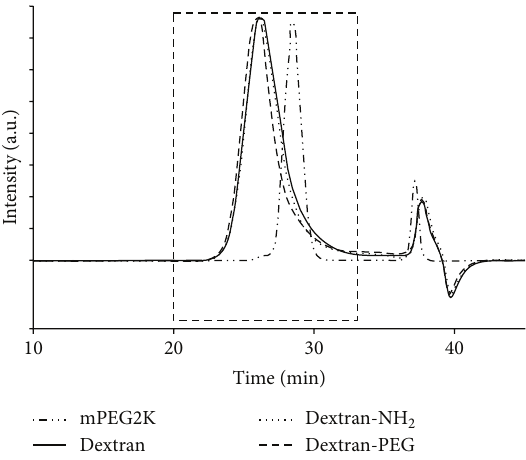
Figure 5: GPC chromatograms of DexPEG block copolymer.